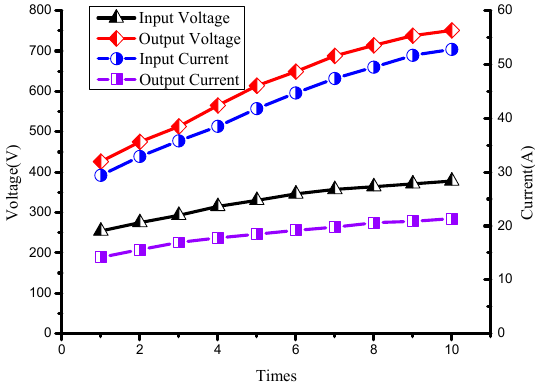
Figure 16. The input voltage, the output voltage, the input current, and the output current.